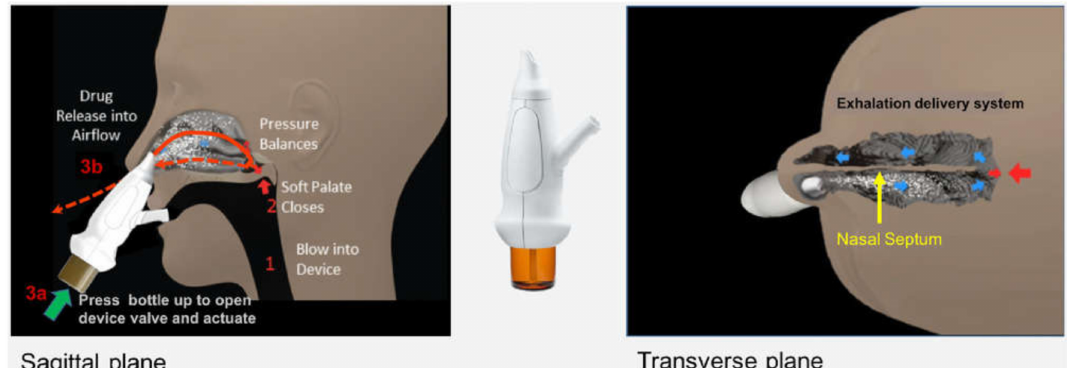
Figure 2. EDS mechanism. The EDS has a flexible mouthpiece and a nosepiece. The sealing nosepiece is shaped to transfer pressure from the mouth, to avoid compression of soft tissue in a way that could obstruct air flow, and to “stent” the nasal valve, particularly superiorly. Exhalation through the EDS (1) creates an airtight seal of the soft palate, isolating the nose from the mouth and lungs; (2) transfers proportional air pressure into the nose; and (3) helps “float” medication around obstructions to high/deep sites in the nasal labyrinth, such as the OMC. The transferred intranasal pressure is proportional, across various exhalation forces, to oral pressure, counterbalancing pressure on the soft palate. This assures a patient communication behind the nasal septum and allows air to escape through the opposite nostril. “Positive-pressure” expands passages narrowed by inflammation (vs. negative pressure delivery, “sniffing”). Use is simple and quick. A patient inserts the nosepiece into one nostril and starts blowing through the mouthpiece. This elevates and seals the soft palate, as with inflating a balloon, separating the oral and nasal cavities. The patient completes use by pressing the bottle to actuate. This causes a coordination-reducing valve to release the exhaled breath concurrently with aerosol spray in a “burst” of naturally humidified air. Reproduced with permission from [84], John Wiley & Sons, Inc.,